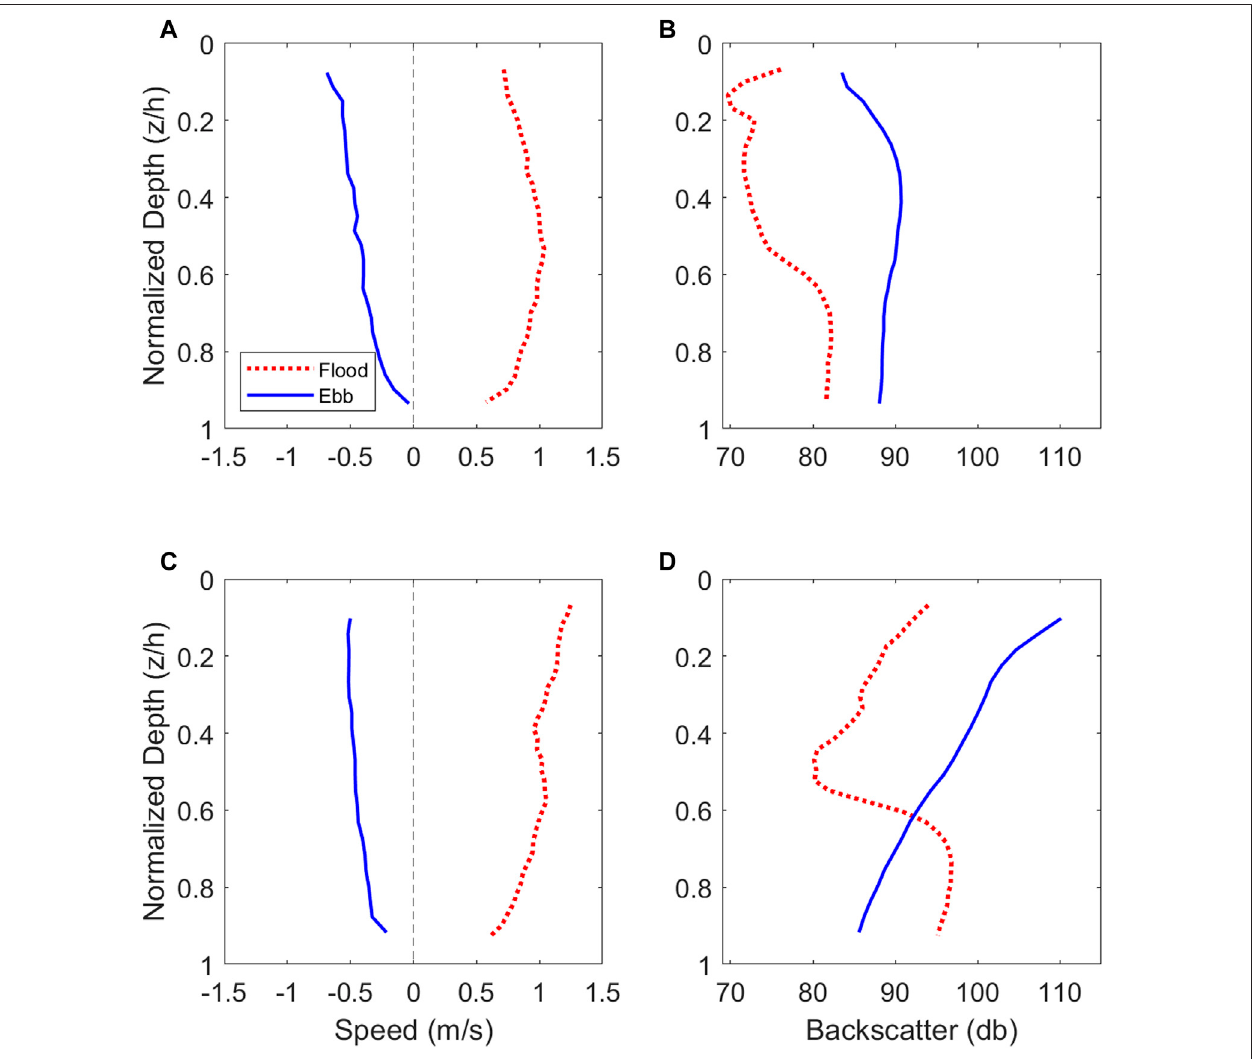
FIGURE 8 | Vertical pro fi les of velocity and backscatter from Transects #5 and #21 taken during Ebb and Flood conditions. The pro fi les averaged the measurements for 1-min; and over1-m depth intervals. Panels (A) and (C) display the velocity components and speed. Panels (B) and (D) show the backscatter return.